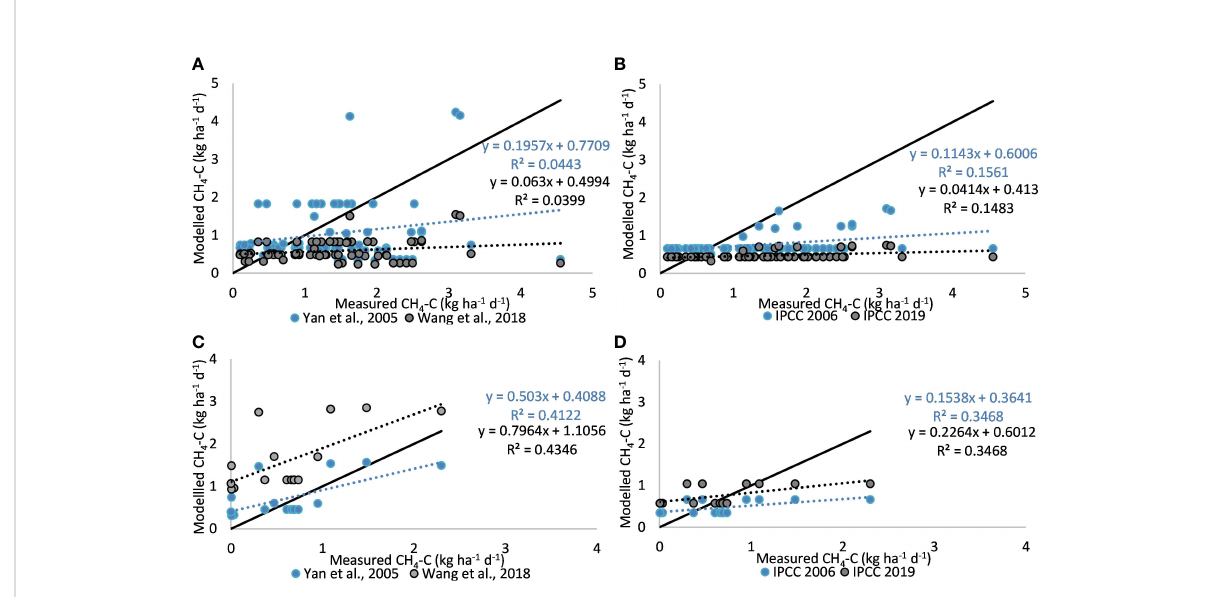
FIGURE 8 Modelled and observed emissions for the temperate regions of USA (A, B) and Europe (C, D) with Yan and Wang tier 3 models in (A, C) and IPCC tier 1 models in (B, D) (solid line indicates 1:1). Sample number = 16 for Europe and 69 for